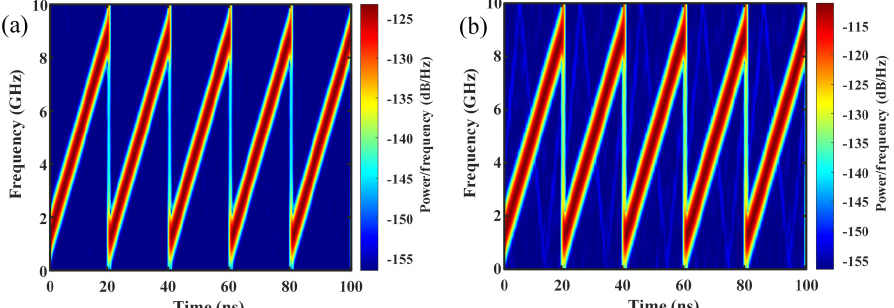
Figure 10. Time-frequency diagram of the LFM signal obtained by using ( a ) the low-speed NPS-based ADC, and ( b ) its equivalent high-speed uniform photonic sampling-based ADC.